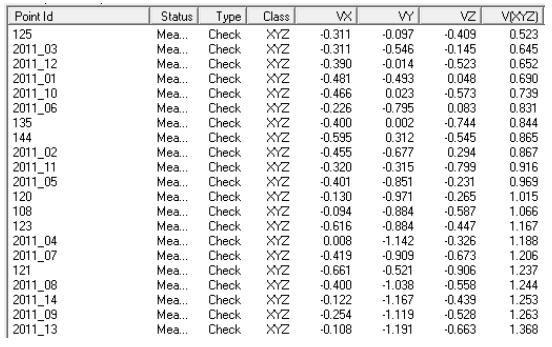
Table 10. Control and Check Point Residuals The RMS values of 21 check points are about 2 to 3 GSDs (27cm) for X, Y, and Z